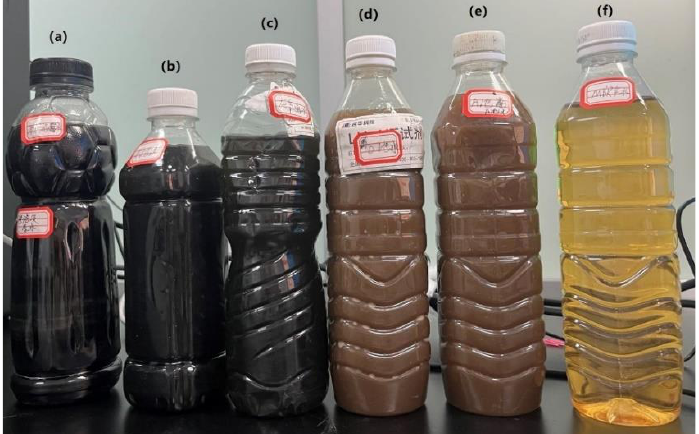
Figure 2. Leachate sample collection: ( a ) leachate raw water (LRW), ( b ) leachate effluent (LE), ( c ) internal circulation reactor effluent (ICRE), ( d ) aerobic effluent (AeroE), ( e ) Anaerobic effluent (ANE), and ( f ) MBR effluent (MBRE).